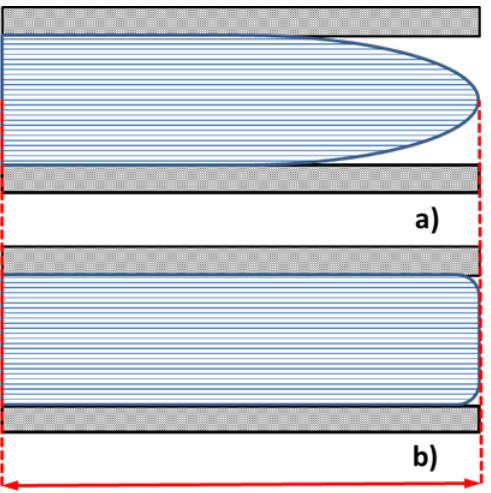
Figure 13. Polymer flow in the mold, at the same length the component is ( a ) incomplete or ( b ) complete.